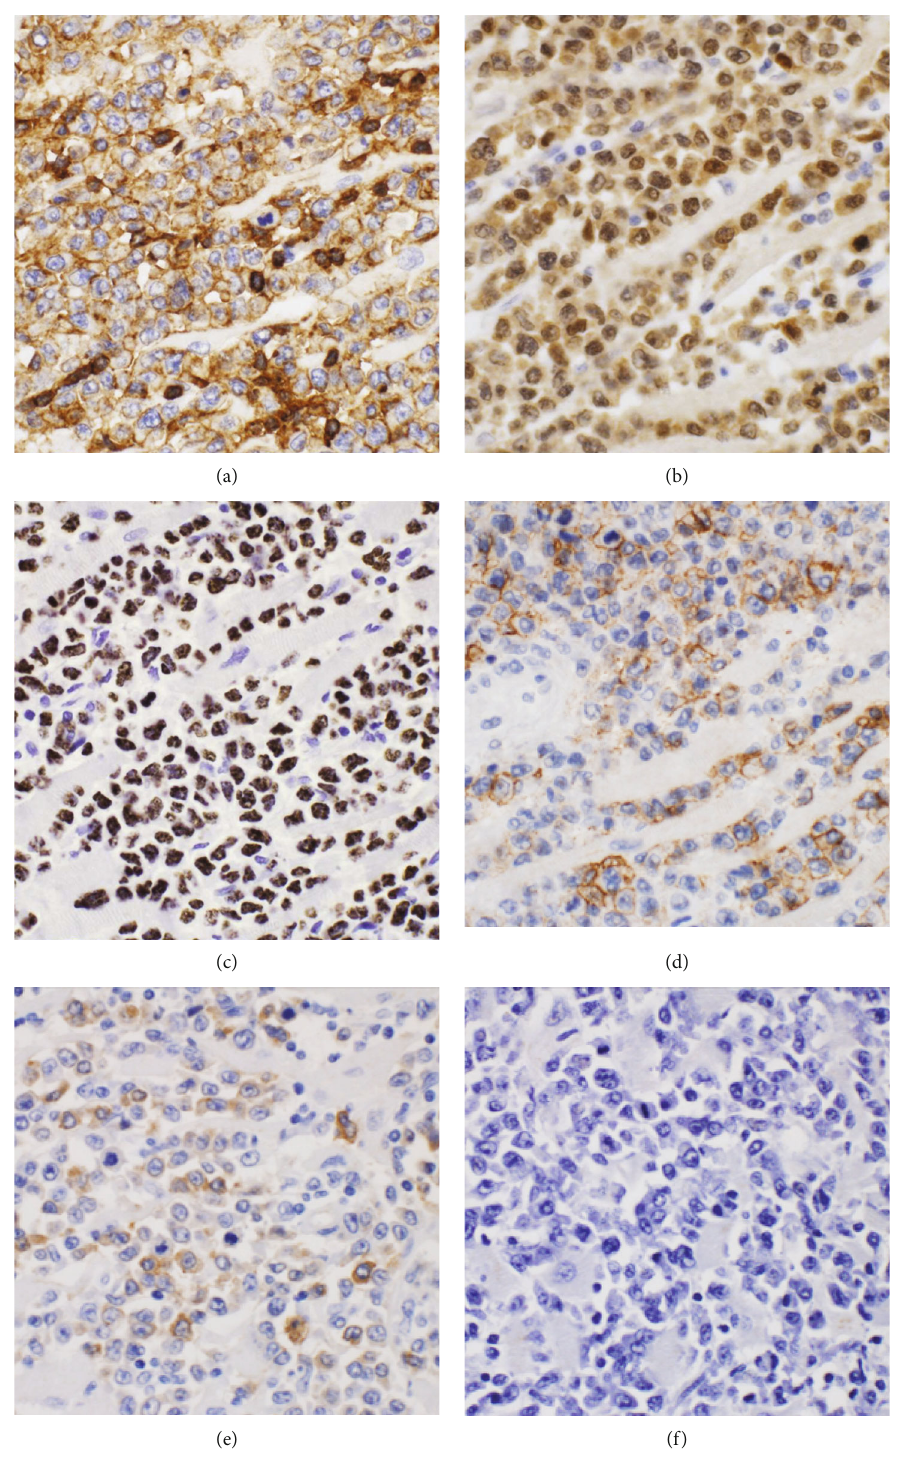
Figure 3: Immunohistochemical staining patterns demonstrated the neoplastic cells were positive for CD45 (a), MUM1 (b), HHV8 (c), CD20, subset (d), and CD30, subset (e). EBV in situ hybridization was negative